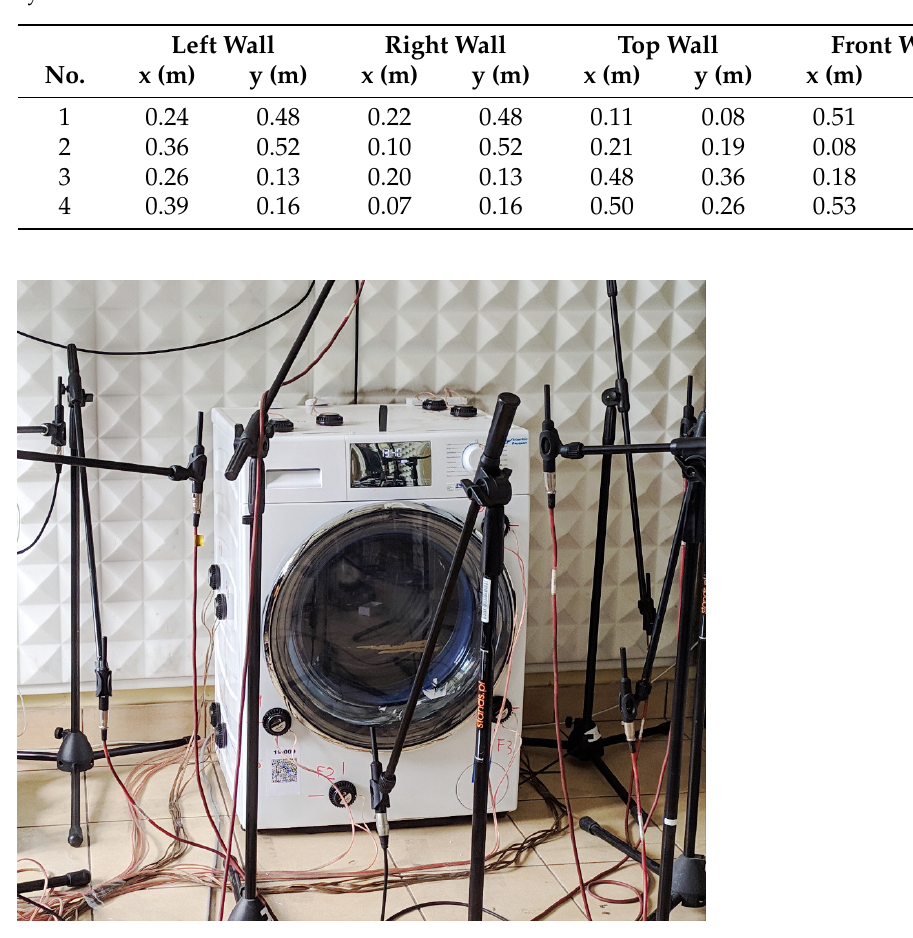
Table 1. Detailed locations of the actuators attached to the casing. The origin of the coordinates system is in the left bottom corner of each wall.